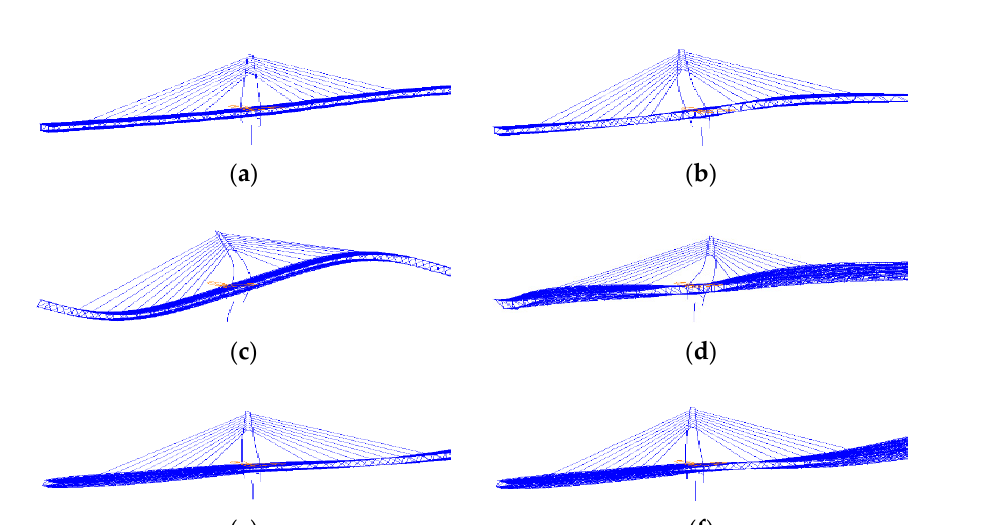
Figure 6. Some vibration modes: ( a ) The 1st-order mode; ( b ) the 5th-order mode; ( c ) the 6th-order mode; ( d ) the 7th-order mode; ( e ) the 8th-order mode; ( f ) the 9th-order mode.